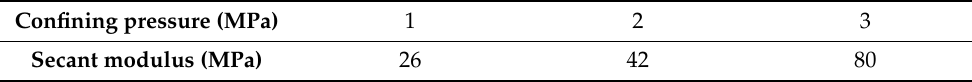
Table 2. Secant modulus of sediments containing spherical hydrates ( 𝑟 = 5𝑚𝑚 ).